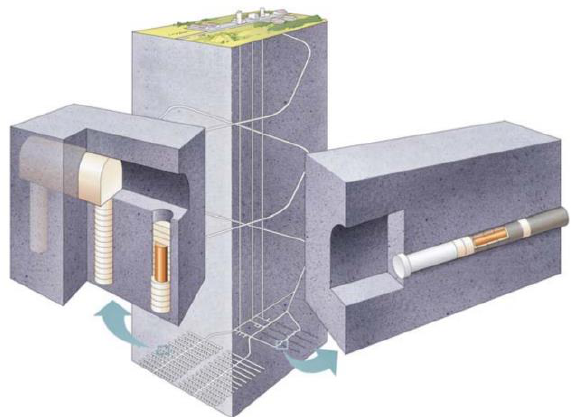
Figure 10. Cross-sectional view of vertical (KBS-3V, left) and horizontal (KBS-3H, right) method of radioactive waste container placement in KBS-3 concept [49].